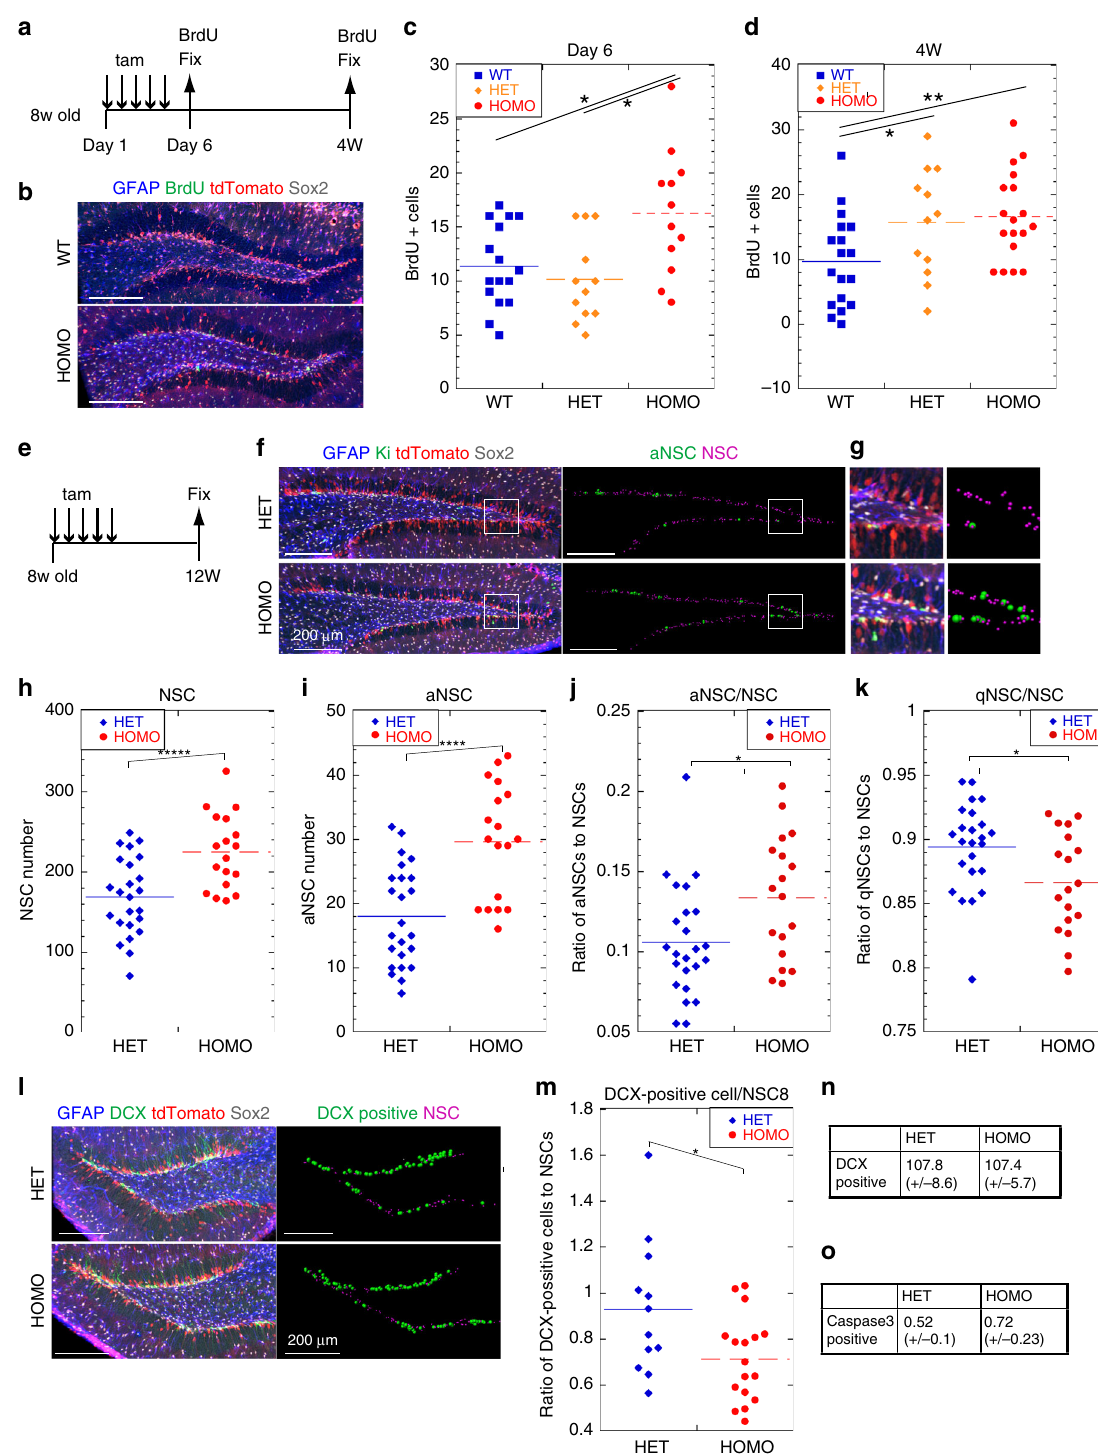
SGZ of Tfeb -cKO mice, TFEB was depleted in tdTomato-positive cells after tamoxifen administration. In brain slices throughout the DG along the rostrocaudal axis, we identi fi ed tdTomato-positive NSCs in the 3D reconstitution by immunostaining for Sox2 and GFAP. To monitor proliferating cells, proliferating NSCs were labeled by BrdU for 2 h before fi xation, and then counted in brain slices in wild type (WT), heterozygote (HET), and homozygote mice (HOMO) on day 6 or at 4 weeks (Fig. 7b). BrdU-labeled aNSCs were signi fi cantly higher in Tfeb -cKO HOMO than in 10 NATURE COMMUNICATIONS| (2019) 10:5446